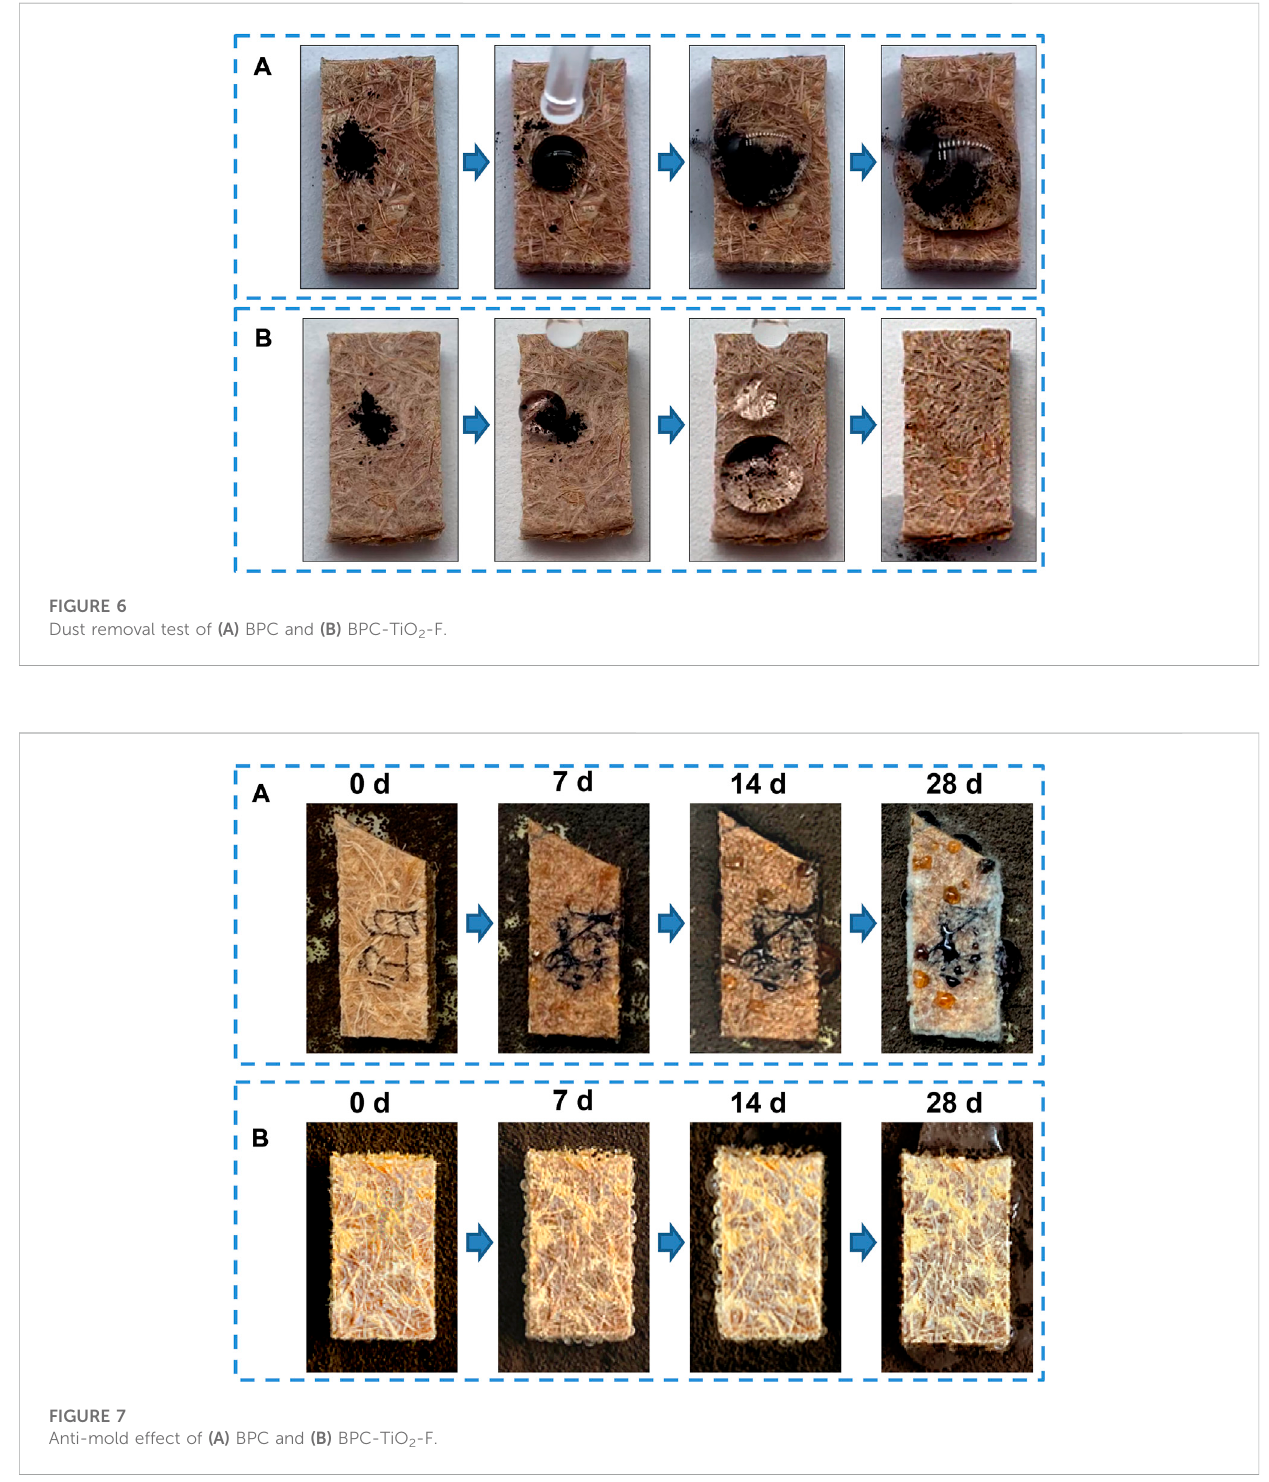
as shown in Figure 6. Black Fe 3 O 4 was sprinkled on the surface of BPC and BPC-TiO 2 -F and then rinsed with water. For the unmodi fi ed BPC, the water droplet wrapped the black powder and adhered to the BPC surface (Figure 6A). The contact angle of the unmodi fi ed BPC was less than 150 ° , so the water droplets showed good wettability to the surface and spread. In contrast, the